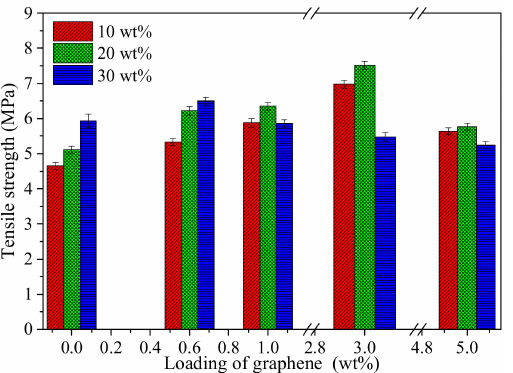
Figure 8. Tensile strengthes of G-TPU films prepared by different initial concentrations of TPU and graphene